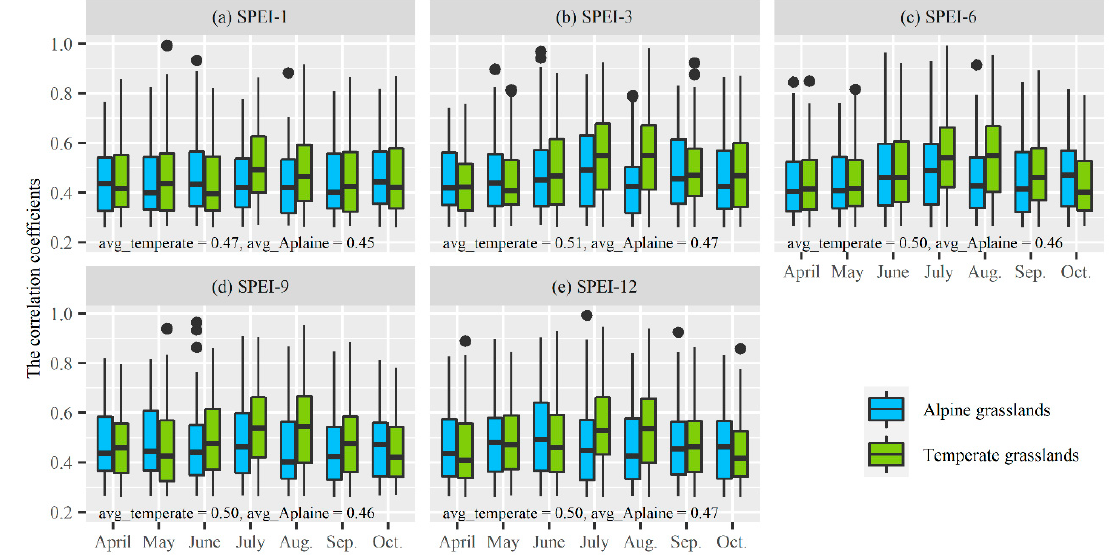
Figure 2. The r values between solar-induced chlorophyll fluorescence (SIF) and standardized precipitation evapotranspiration index (SPEI) for temperate grasslands and alpine grasslands under 1 month ( a ), 3 months ( b ), 6 months ( c ), 9 months ( d ), and 12 months ( e ). All the reported correlation coefficients are statistically significant ( p values < 0.05).